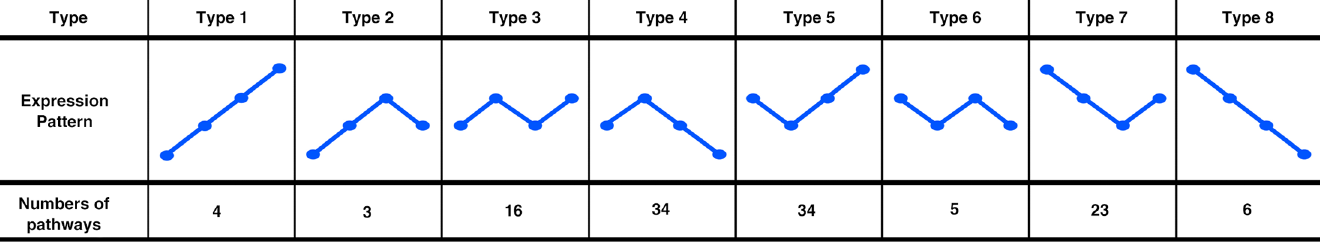
Fig 7. An overview of eight types of expression patterns of the genes from different